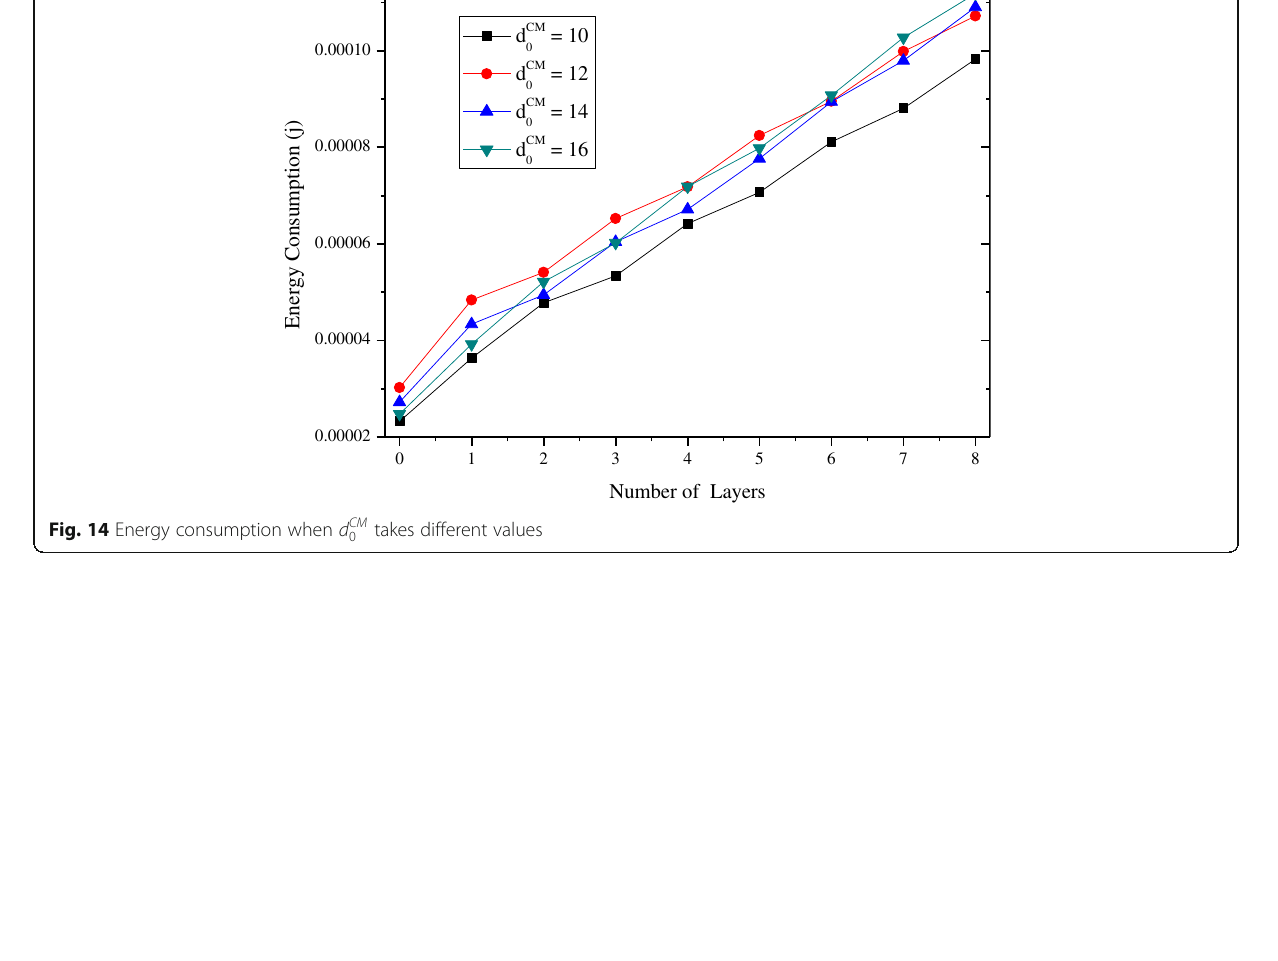
takes different values 0